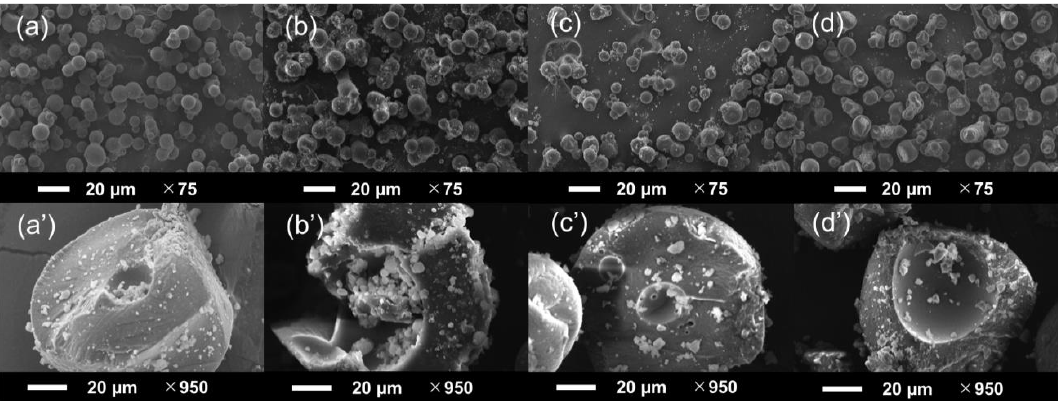
Figure 2. SEM micrographs of spray-dried powders with various wall materials. Suc: ( a and a ’), Lac: ( b and b ’ ), maltodextrin (MD) (dextrose equivalent (DE) = 25): ( c and c ’), and MD (DE = 19): ( d and d ’). ( a , b , c , d ) show surface and ( a ’, b ’, c ’, d ’) show cross-cut